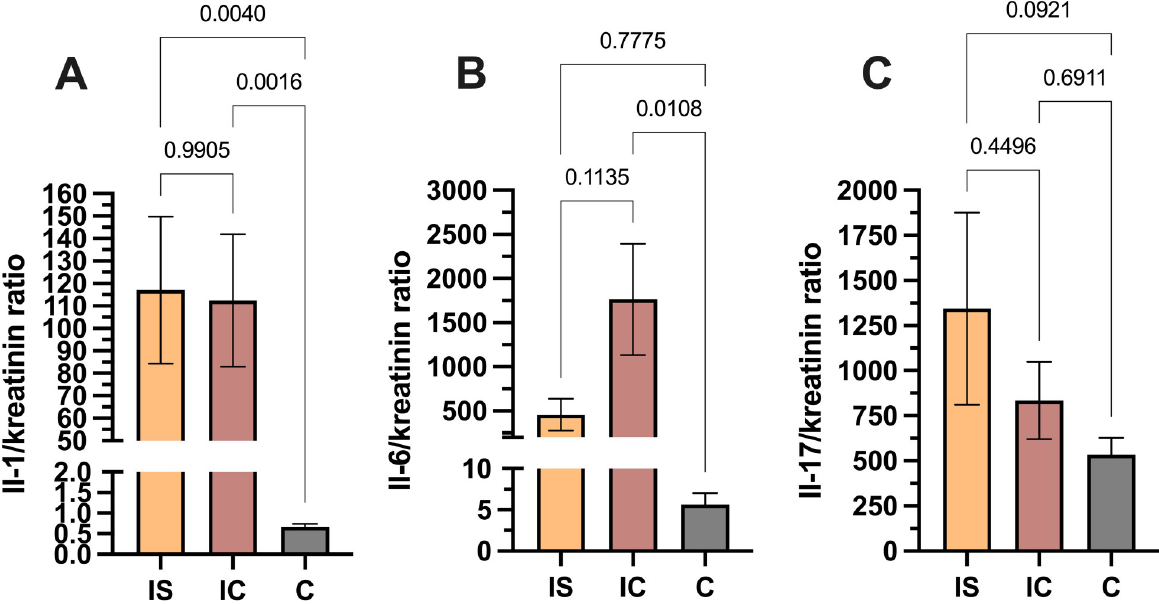
Fig 1. Differences in cytokine concentrations between kidney recipients (immunosuppressed—IS), immunocompetent UTI-affected hosts (IC), and controls (C). A displays a significant difference in IL1 β concentrations between IS and IC and controls and no significant difference between IS and IC groups. B depicts a considerable difference in IL6 concentrations between IC and controls and no significant difference both between IS and IC as well as IS and controls. There is also low diversity in IL 6 urine concentrations in IS group. C displays no significant differences in IL 17 concentrations between any of the groups. However, there is an increased diversity in urine IL17 concentrations in IS group.